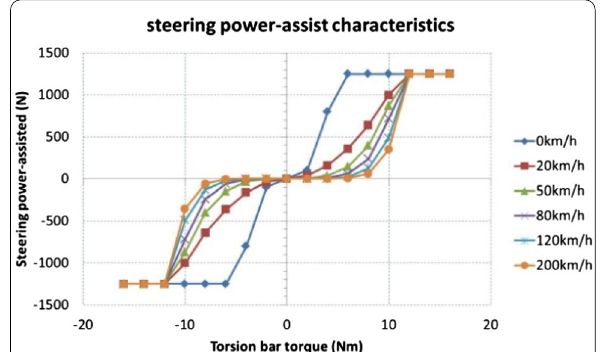
Figure 1 Steering power-assist